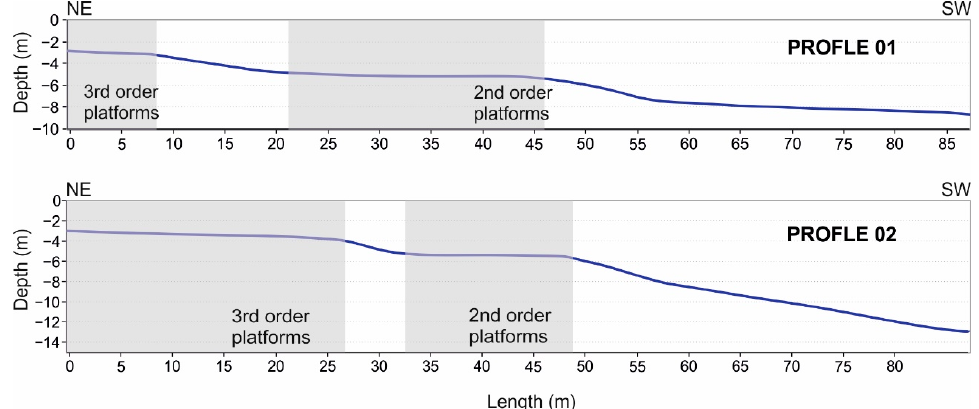
Figure 13. NE–SW profiles of the two relicts of the submerged paleo-shore platforms; for their location see Figure 11b. see Figure